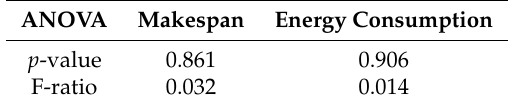
Table 5. One-way analysis of variance (ANOVA) comparing Mk and EC of the proposed method.